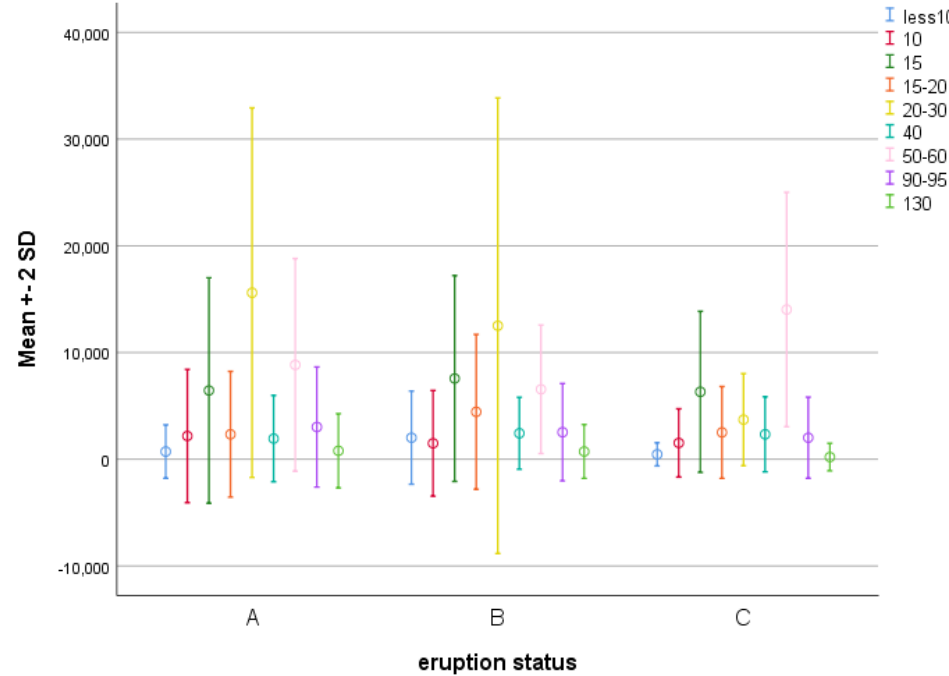
Figure 1. Means ± SD concentrations of proteins with different molecular weights in the three groups.